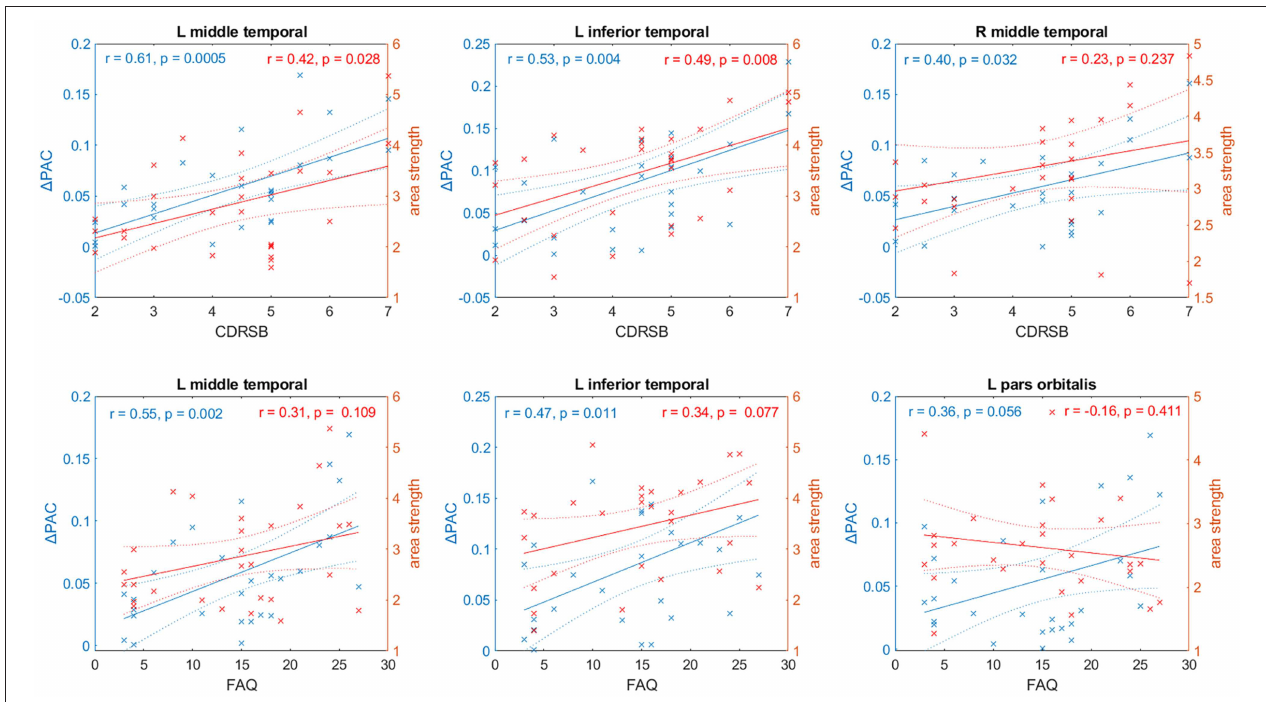
FIGURE 10 | Relationship between two cognitive tests– CDRSB and FAQ– and PAC (in blue) and values of the node strength (in red) for selected areas of the AD networks. Solid and dashed lines represent the linear fit and confidence intervals,